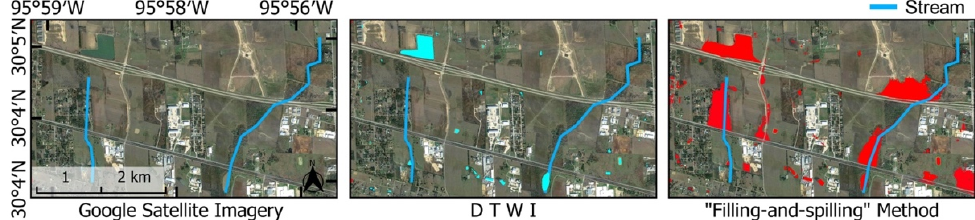
Figure 9. Delineated area for the DTWI and the “filling-and-spilling” method.